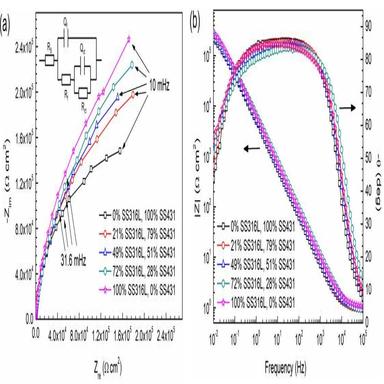
(a) Nyquist plots, (b) bode plots at different SS316L content zones in 3.5 wt.% NaCl solution, used the SDC test system. The corresponding equivalent circuit is shown as inset at the left corner in Fig. (a).